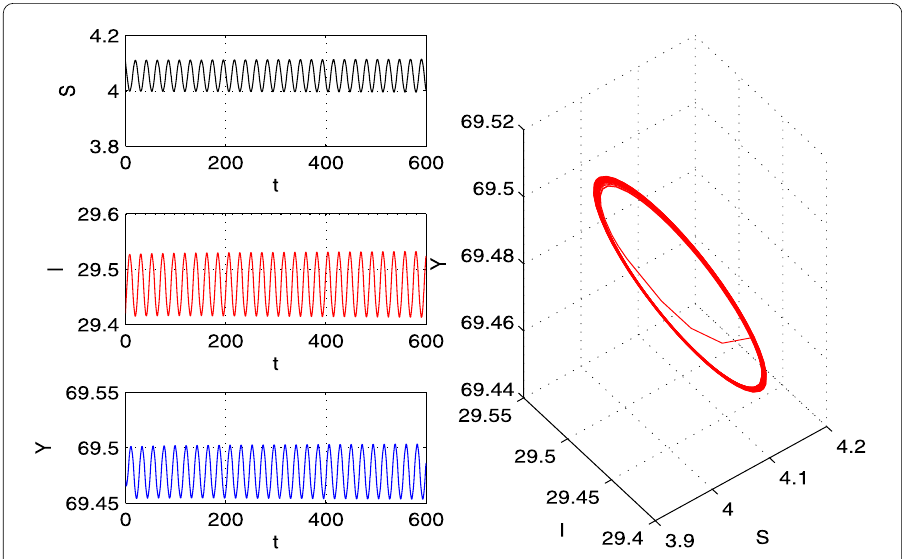
Figure 3 The trajectories of system (4.1) with τ 1 = 5.88 > τ 10 = 5.8744, τ 2 = 0. A Hopf bifurcation occurs from the positive equilibrium E . The initial value is (4,29.5,69.5)